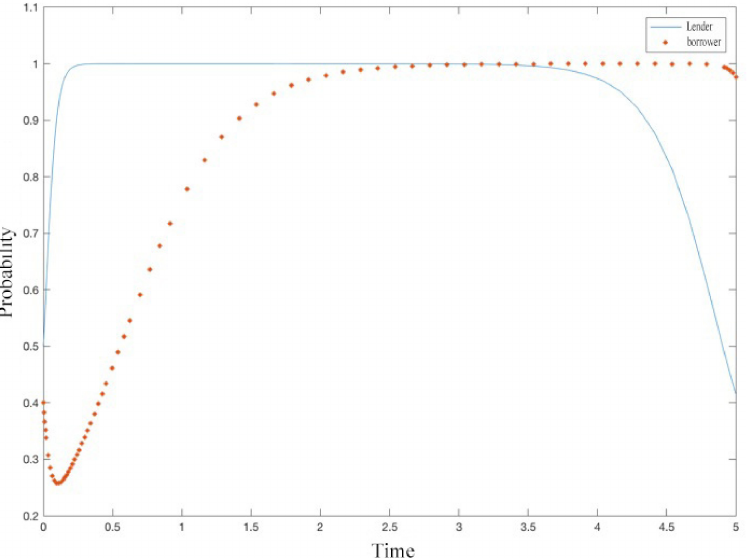
Figure 6. The dynamic evolutionary process of the active online lending platform when it charges investors higher information